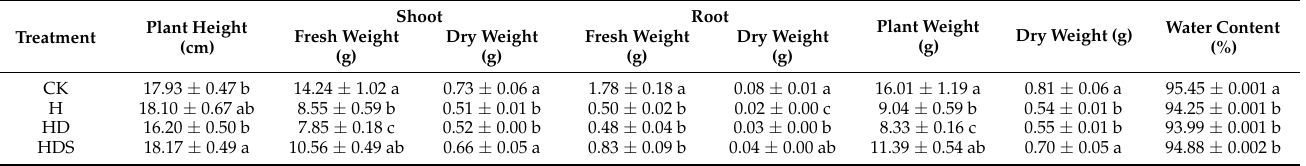
Table 1. Effects of exogenous spermidine and D-arg on growth indicators of lettuce under high- temperature stress.